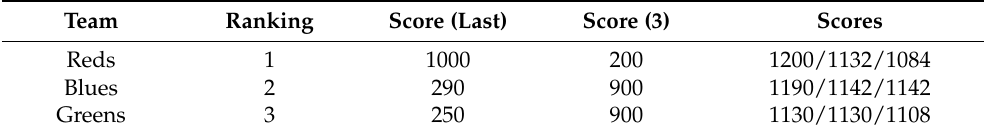
Table 4. Play-off reverses rankings inversely to